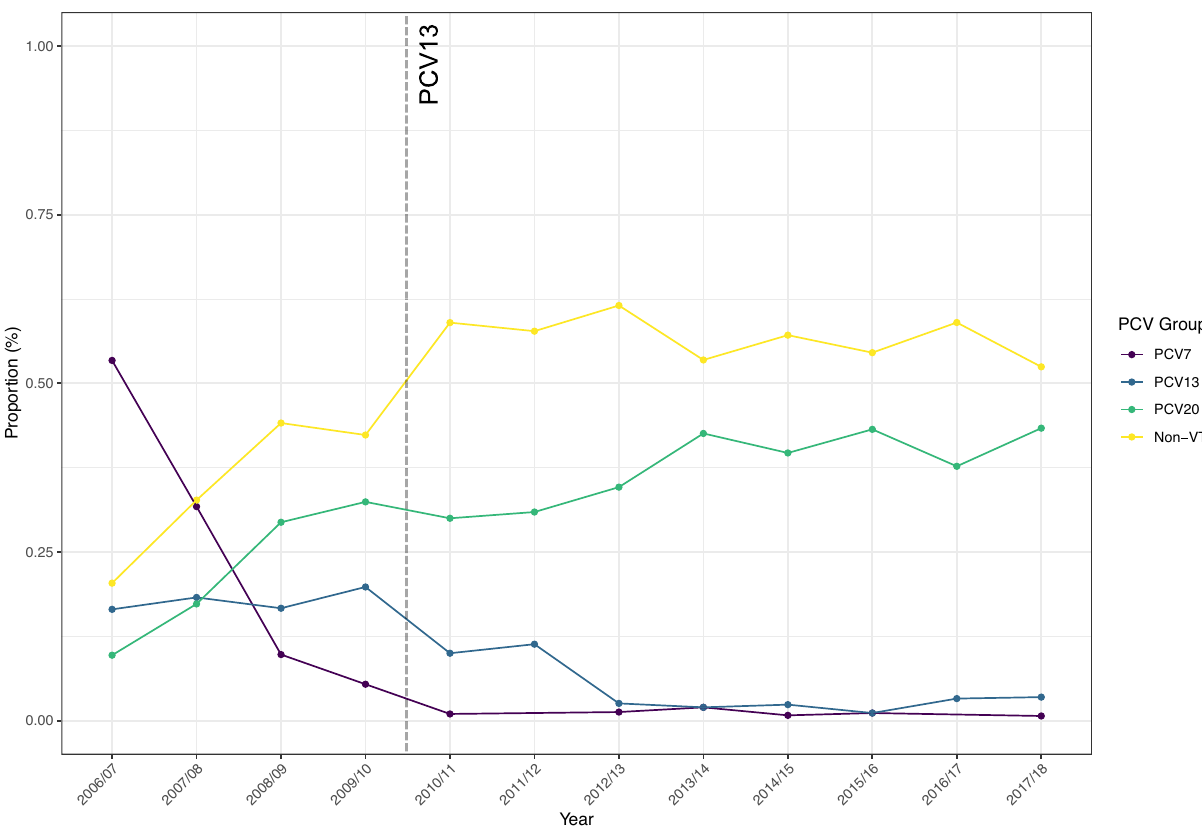
Figure 5. Prevalence of serotypes grouped by inclusion in PCVs, noting the reduction in PCV7 serotypes post-PCV7 from > 50% (purple) and of PCV13 serotypes (blue) from a high of ~ 20% post-PCV13. Serotype replacement with NVTs, here split to illustrate those that will be targeted by PCV20, equates to 95% of carriage in